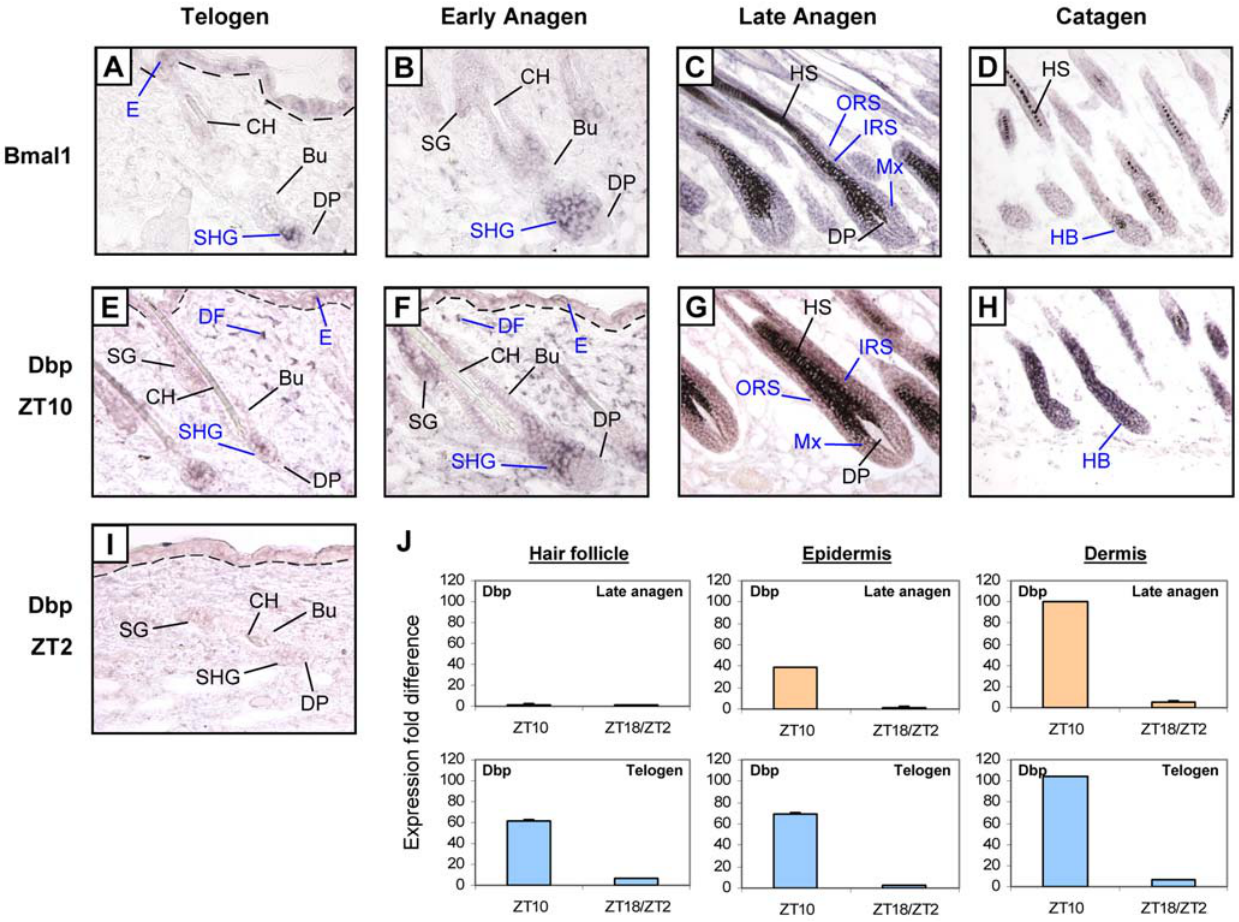
Figure 4. Bmal1 and its target gene Dbp are co-expressed during hair follicle cycling. In situ hybridization staining of telogen, early anagen, late anagen, and catagen dorsal skin at ZT10 with Bmal1 (A–D) and Dbp (E–H) probes. (I) Dbp expression at ZT2 in telogen skin. Dashed lines indicate border between epidermis and dermis. Note that the black pigment of the hair shaft in late anagen hair follicles is not hybridization signal. Bu – bulge, CH – club hair, DP – dermal papilla, HB – hair bulb, HS – hair shaft, IRS – inner root sheath, Mx – matrix, ORS – outer root sheath, SHG – secondary hair germ, SG – sebaceous gland. (J) Dbp expression from laser capture microdissected hair follicles, dermis, and epidermis for telogen and late anagen dorsal skin at ZT10 and ZT18/ZT2. Standard deviations were determined by using three replicates normalized to Gapdh . Ct values indicate detectable expression of clock genes in every sample, and fold was calculated relative to the lowest expression sample.